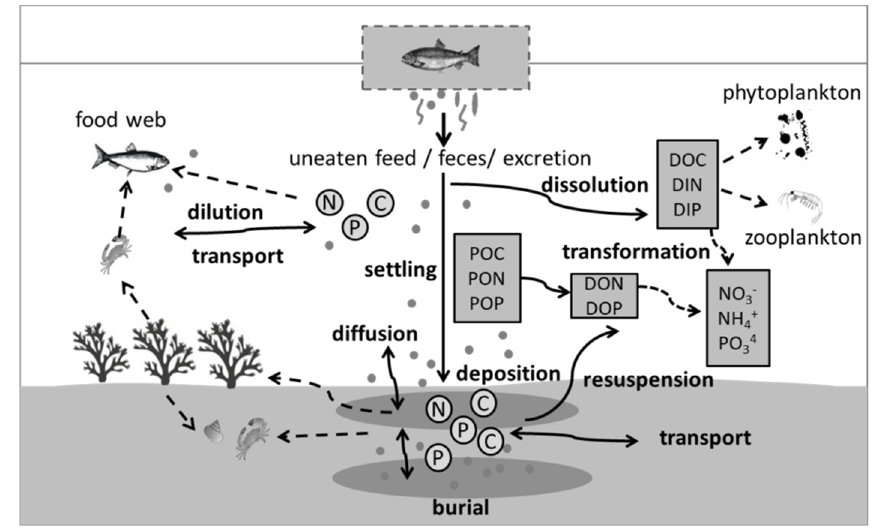
Figure 3. Schematic diagram of mariculture effluent transport and transformation processes.